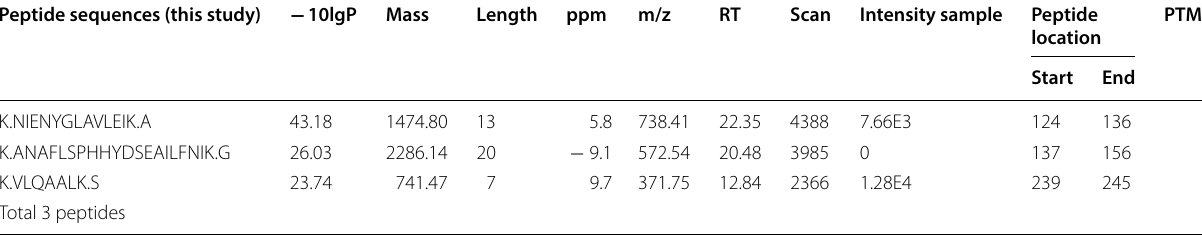
These peptide sequences were matched and compared using NCBI BLAST. The result of purified lentil lectin, in this study, showed high similarity (100%) to p54 protein that was found in pea 10lgP Conversion form of P‑value in PEAKS 8.5 software where P‑value of 1% is equivalent to ‑10lgP of 20 − = ppm delta Mass is the deviation of measured mass from the theoretical mass of the peptide, in ppm, m/z mass of ions (in gas phase) per charge, RT relatively accurate prediction of peptide, PTM post translational modification